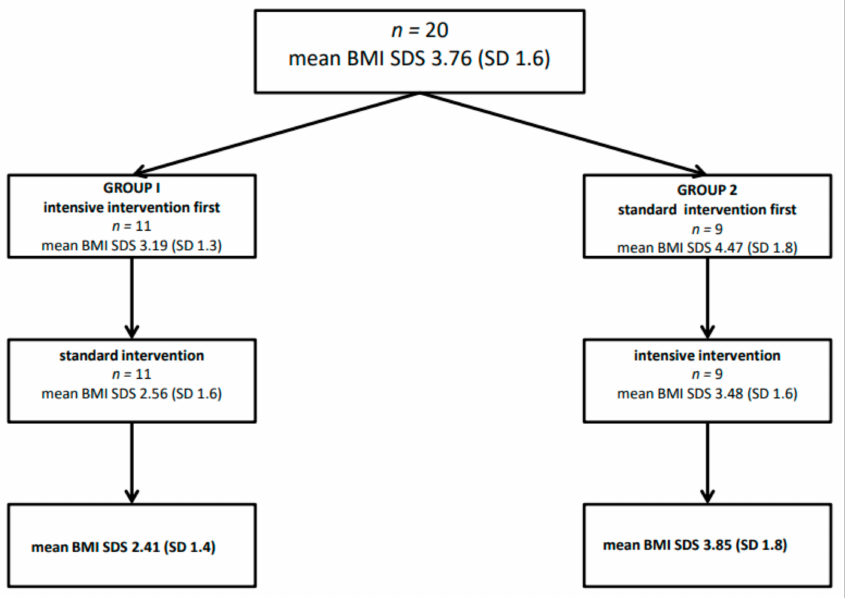
Figure 1. Reduction of body mass index BMI (SDS) in both arms of the